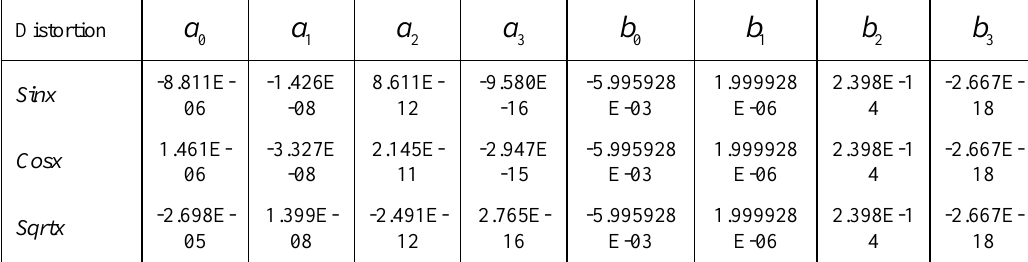
Table 2. Initial internal parameters for different distortions